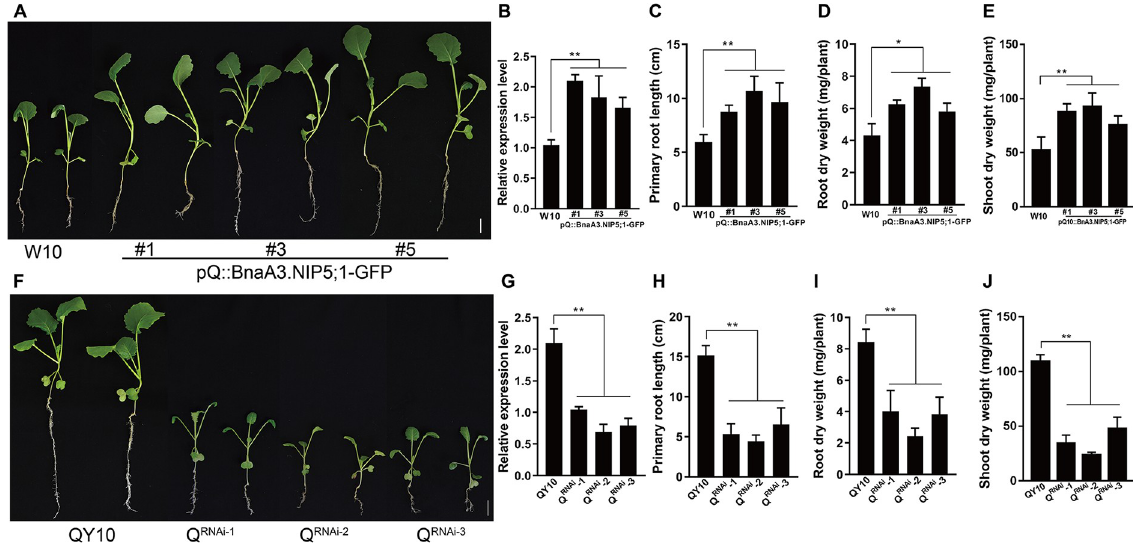
Fig 1. Response of WT and transgenic plants to B deficiency. ( A ) Phenotype of 15-d-old WT (W10) and pQ::BnaA3.NIP5;1-GFP transgenic plants grown under low-B (0.25 μ M) conditions. Scale bar, 2 cm. ( B-E ) Relative expression of BnaA3 . NIP5;1 ( B ), primary root length ( C ), root dry weight ( D ) and shoot dry weight ( E ) of W10 and pQ::BnaA3.NIP5;1-GFP transgenic plants under low-B (0.25 μ M) conditions. ( F ) Phenotype of 15-d-old WT (QY10) and QY10-RNAi lines grown under low-B (0.25 μ M) conditions. Scale bar, 2 cm. ( G-J ) Relative expression of BnaA3 . NIP5;1 ( G ), primary root length ( H ), root dry weight ( I ) and shoot dry weight ( J ) of QY10 and QY10-RNAi lines under low-B (0.25 μ M) conditions. The data presented are mean values with s.d. (three replicates in ( B and G ); six replicates in ( C , D , E , H , I and H ). � P < 0.05, �� P < 0.01 (Student’s t